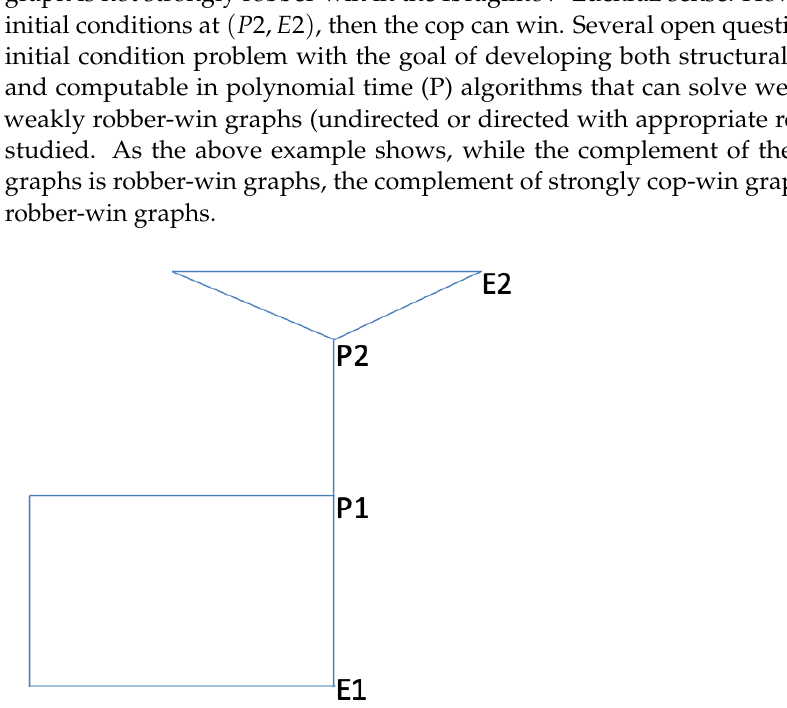
Figure 1. The Initial Condition Problem: possibilities of both pursuit and evasion depending on initial